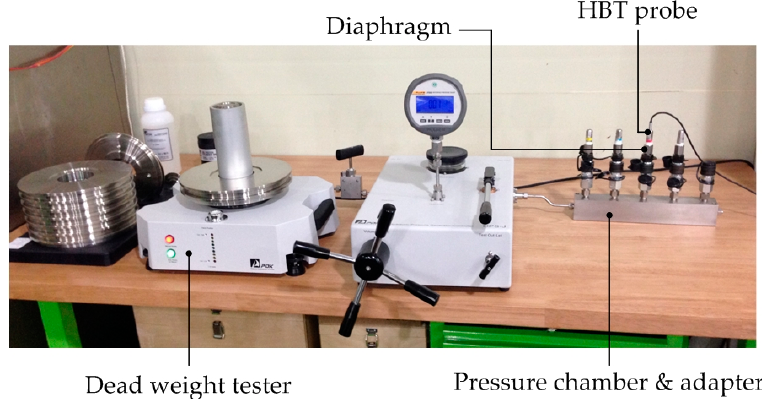
Figure 11. Diaphragm deflection measurement equipment with pressure varied by dead weights.